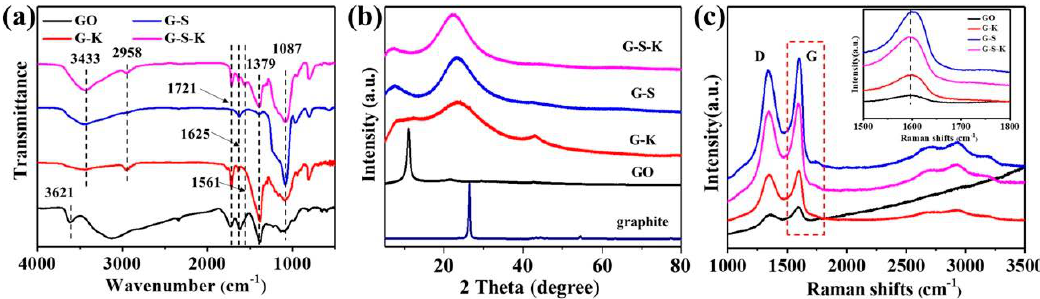
Figure 3. ( a ) FTIR spectra, ( b ) XRD patterns, and ( c ) Raman spectra of GO, G-K, G-S, and